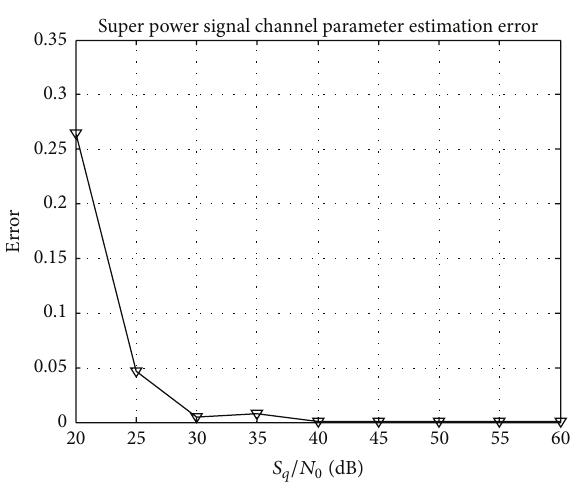
Figure 11: Influence of the strong interference signal on the mixed weak signals with the proposed Interference Cancellation algorithm (IC-algorithm).